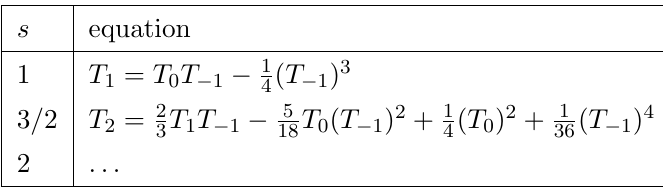
Table 1 . Equations for the Laurent coe(cid:14)cients of the solitonic T vv ( v